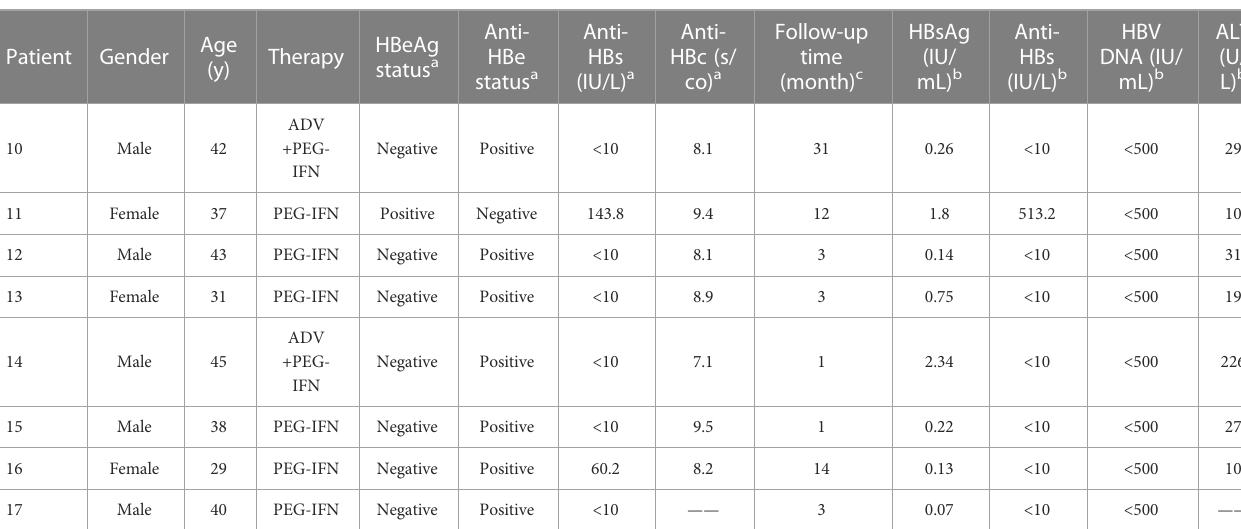
The respective ROC curves of the anti-HBs level and anti-HBc at EOT for the incidence of HRV at 6, 12, 18, 24, 30, and 36 months after the start of follow-up were shown in Figures 3A, B respectively.